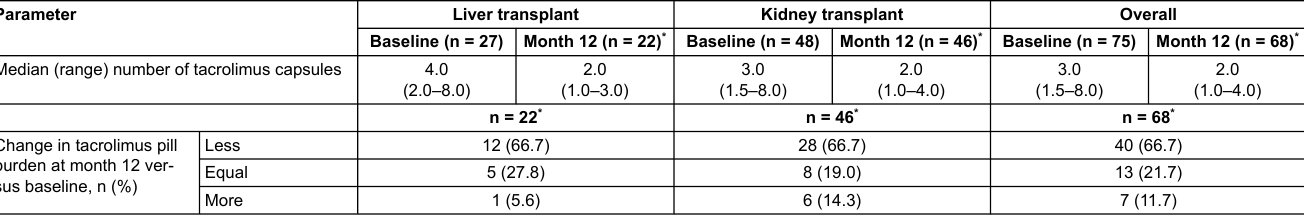
Table 3: Daily intake of tacrolimus (number of capsules) at baseline (immediate-release tacrolimus) and month 12 (prolonged-release tacrolimus), and the proportion of patients reporting a change in tacrolimus pill burden between baseline and month 12, stratified by transplanted organ and overall (full analysis set).